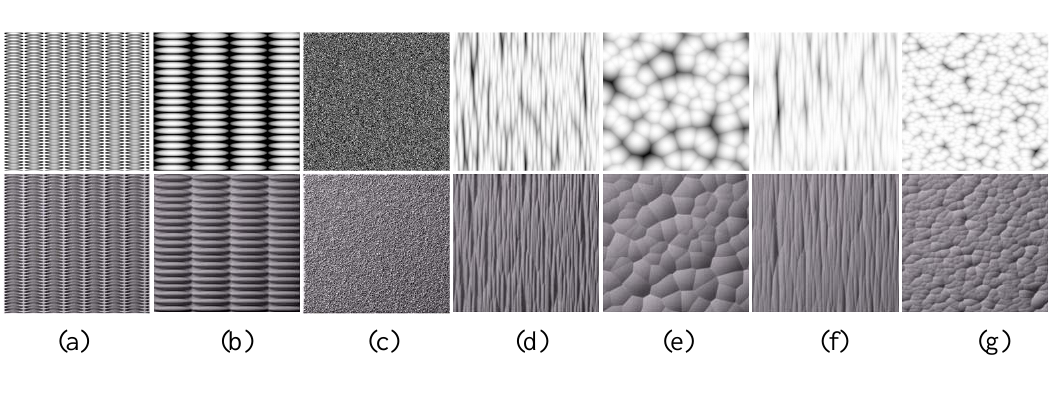
Figure 4. Textures generated by ellipsoids placed using different placement rules: ( a , b ) are samples generated by a regular grid rule; ( c ) is generated by a random grid rule; ( d , e ) are generated by a random walk rule; and ( f , g ) are generated by a probability map rule. Samples in the first row are height maps and samples in the second row are relighting